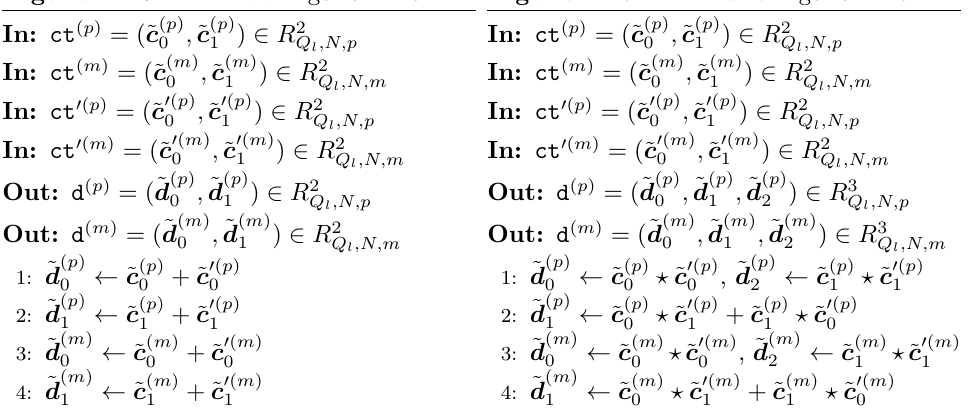
Algorithm 6 HEAAN . Add Algorithm for 2 N Algorithm 7 HEAAN . Mult Algorithm for 2